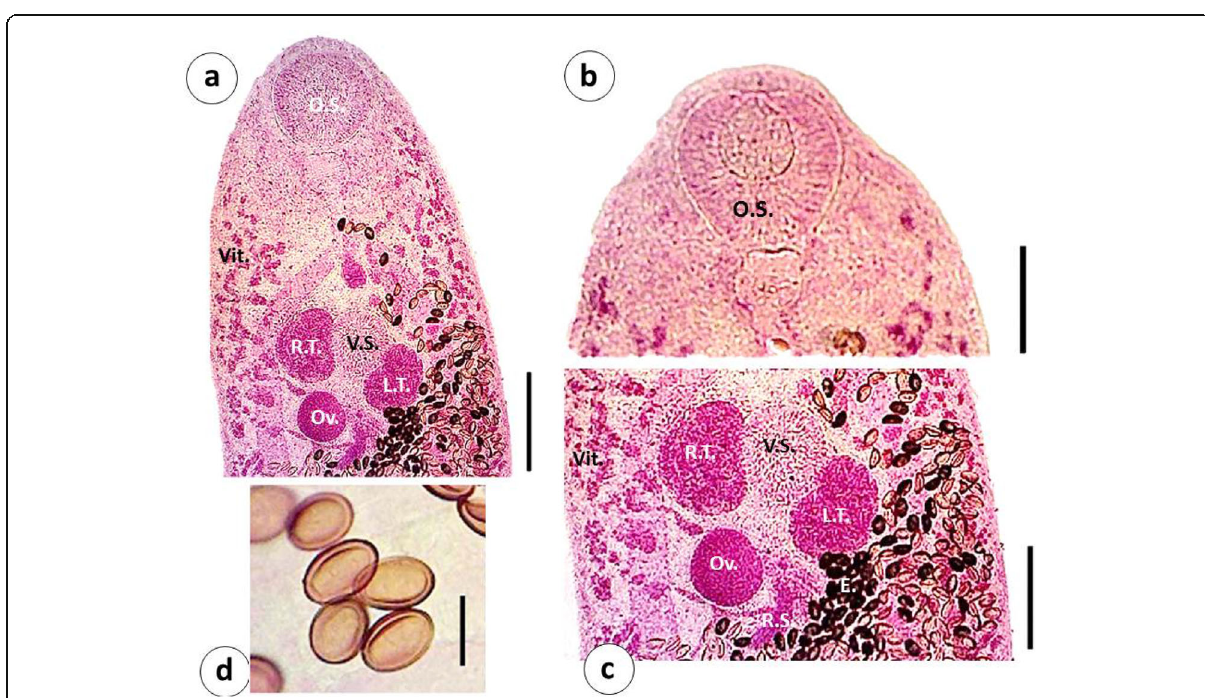
Fig. 3 Photomicrographs of Mesocoelium sociale . a magnified anterior worm body Shows left testis (L.T.), oral sucker (O.S.), ovary (Ov.), right testis (R.T.), vitellaria (Vit.), ventral sucker (V.S.). Scale bar = 300 μ m. b Shows magnified oral sucker (O.S.). Scale bar = 200 μ m. c Shows details of eggs (E.), left testis (L.T.), ovary (Ov.), receptaculum seminis (R.T.), right testis (R.T.), vitellaria (Vit.), and ventral sucker (V.S.). Scale bar = 200 μ m. d Shows the eggs. Scale bar = 30 μ